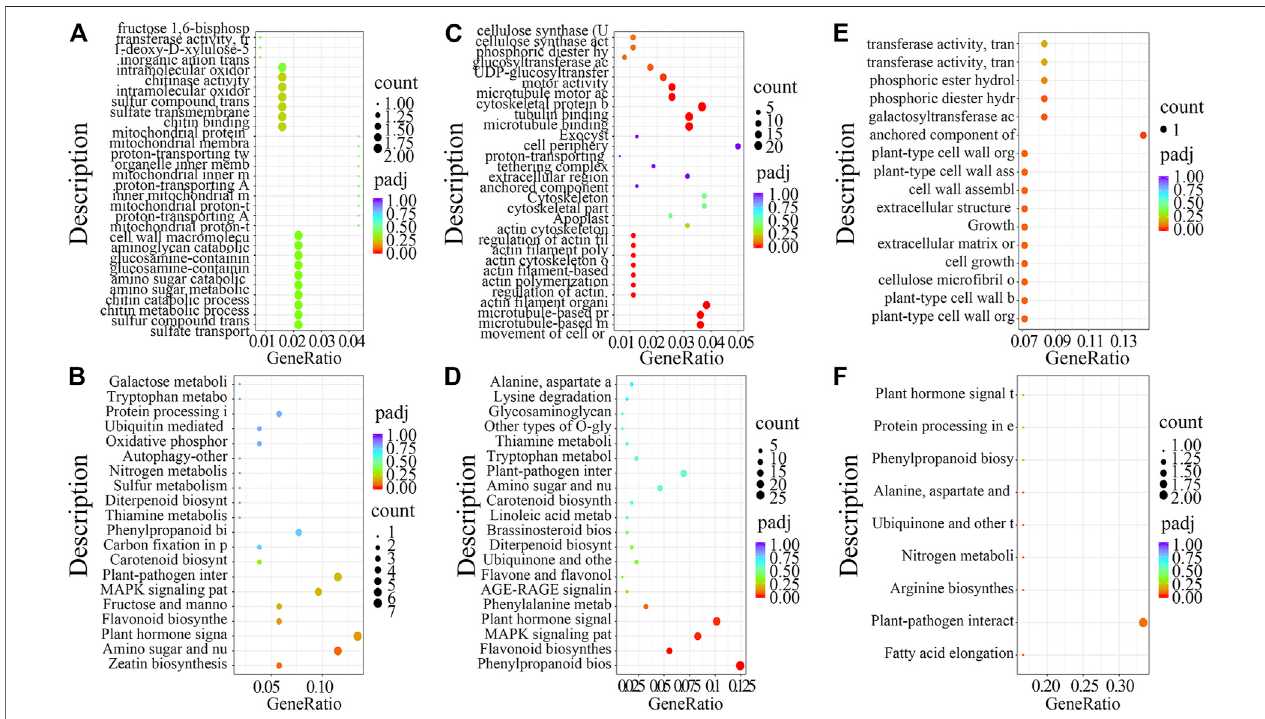
FIGURE 2 | GO and KEGG enrichment analysis of differentially expressed genes (DEGs) from the RNA-seq dataset. GO analysis of DEGs identi fi ed in TW vs. NW (A) , OW vs. NW (C) , and TW vs. OW (E) . KEGG analysis of DEGs identi fi ed in TW vs NW (B) , OW vs NW (D) , and TW vs OW (F) , respectively.